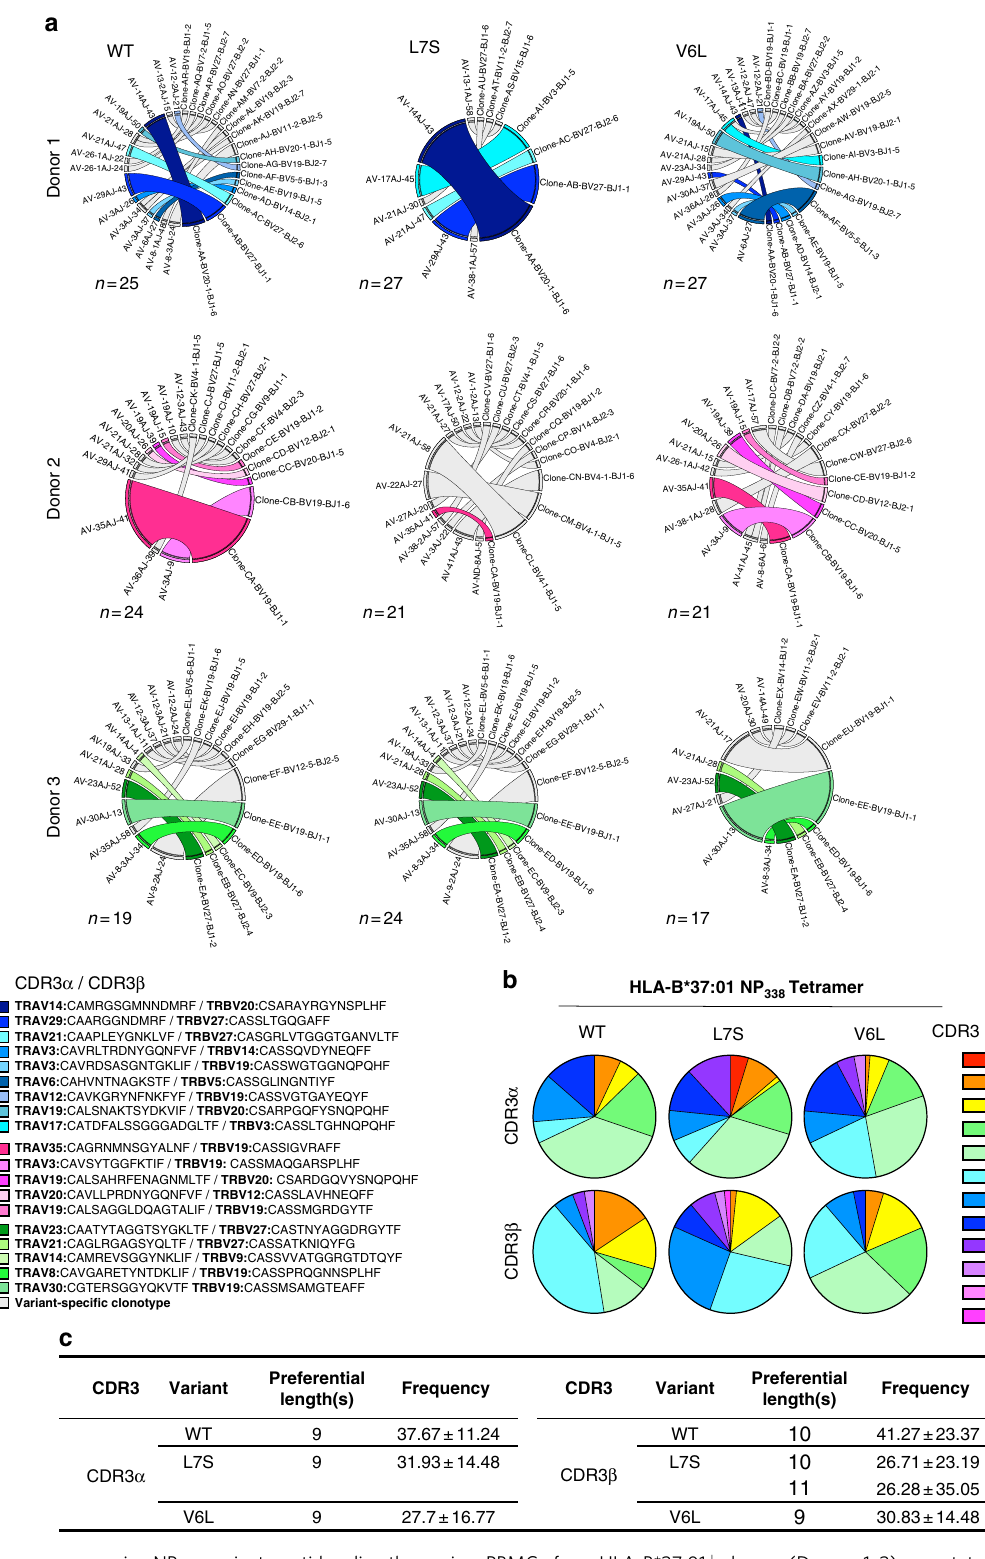
Fig. 5 Key TCRs cross-recognize NP 338 variant peptides directly ex vivo. PBMCs from HLA-B*37:01 + donors (Donors 1 – 3) were tetramer stained individually with each of the NP 338 tetramers conjugated to PE, enriched, and single-cell sorted on lymphocytes, singlets, CD3 + live + dump − cells, CD8 + tet + cells; as per Supplementary Figure 2c. The TCR αβ repertoire was determined using a multiplex RT-PCR. a Graphical representation of the TCR αβ repertoire used by each of three donors for the recognition of variant NP 338 peptides. b Average CDR3 α and CDR3 β length used for the recognition of NP 338 from HLA-B*37:01 + donors. c Preferred CDR3 α and CDR3 β length of NP 338 -speci fi c cells isolated from HLA-B*37:01 + donors in the recognition